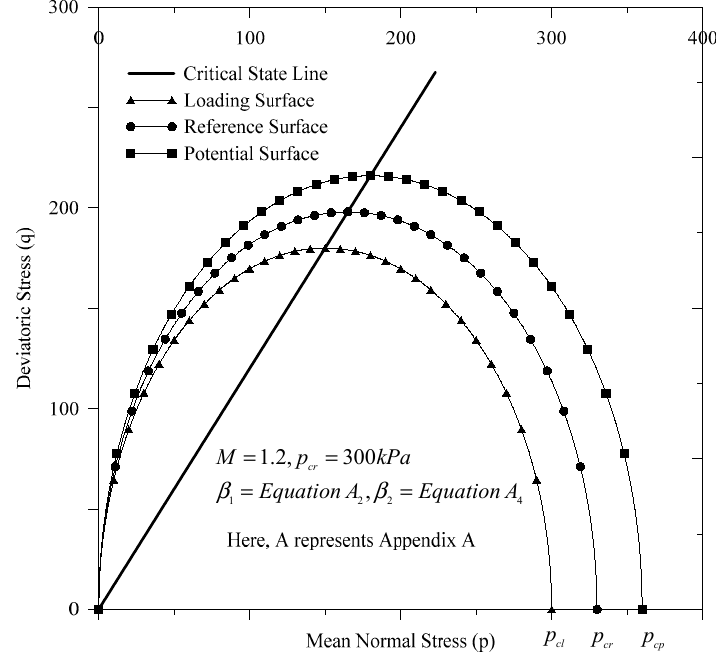
Figure 1. Illustration of the reference surface, the loading surface, and the potential surface in the 𝑝 − 𝑞 plane.